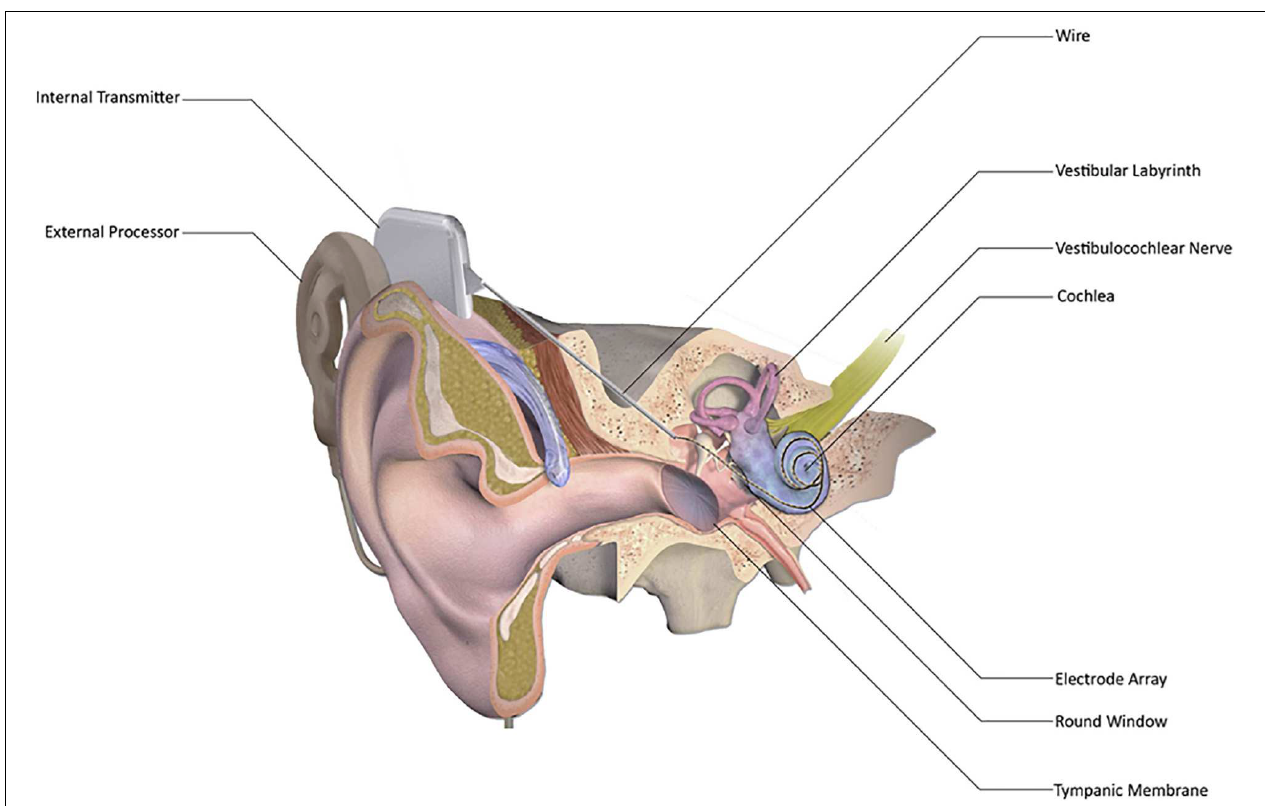
FIGURE 1 | Schematic representation of cochlear implant (CI). CI has external processor that consists of a microphone, a digital sound processor, a battery, and an antenna that communicates with the internal processor. The internal processor receives sound information from the external processor and transmits it to the cochlea via a wire and electrode array inserted into the scala tympani, thereby enabling sound perception. [Adapted from “Cochlear Implant” by BruceBlaus {Blausen.com staff (2014). “Medical gallery of Blausen Medical 2014”. WikiJournal of Medicine 1 (2)} used under CC BY 3.0/Modified for clarity